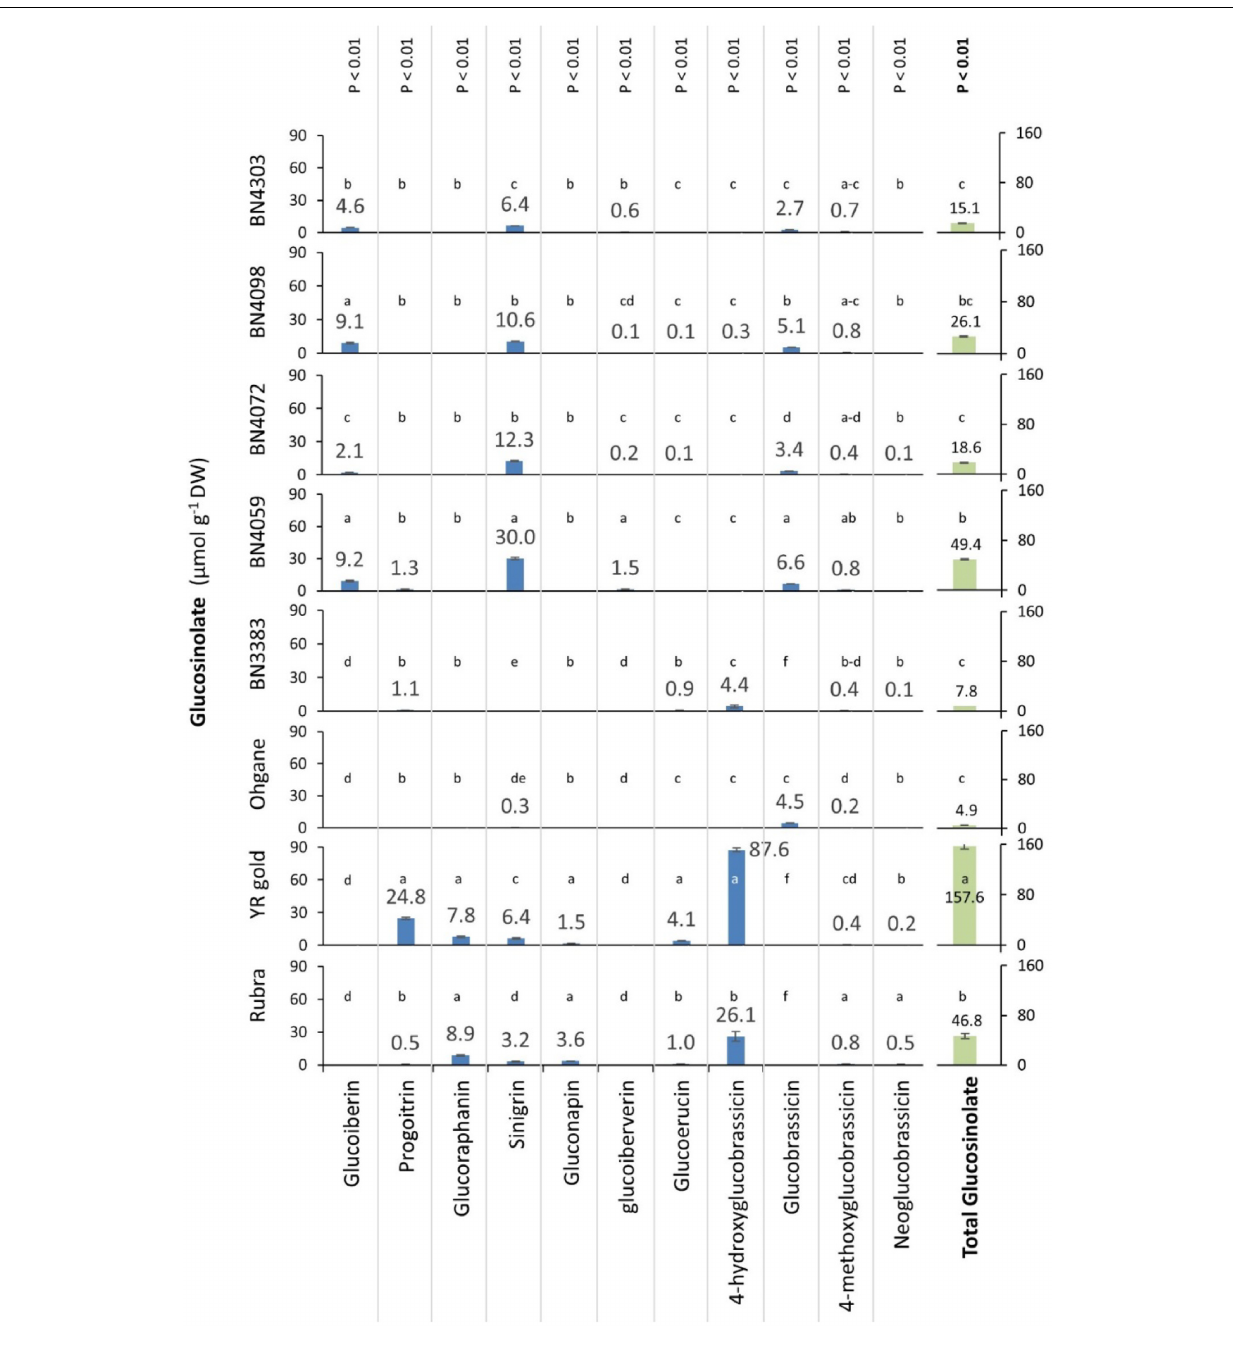
FIGURE 3 | Constitutive glucosinolate contents ( µ mol g − 1 dry weight) in the leaf samples of eight cabbage genotypes. Leaf tissue was harvested from the middle aged fully grown leaves of the 3 months old cabbage before insect infestation and analyzed using HPLC (Waters 2695, Milford, MA, United States) and Mass Spectrophotometry (Agilent 1200 series, Agilent Technologies) systems. Data presented as mean ( n = 3 ± SE). Genotypes varied significantly for individual and total glucosinolate contents ( p < 0.01) as determined by one-way ANOVA. Different letters (a, b, c, etc.) across genotypes indicate statistically significant differences for glucosinolate contents as per Tukey’s pairwise